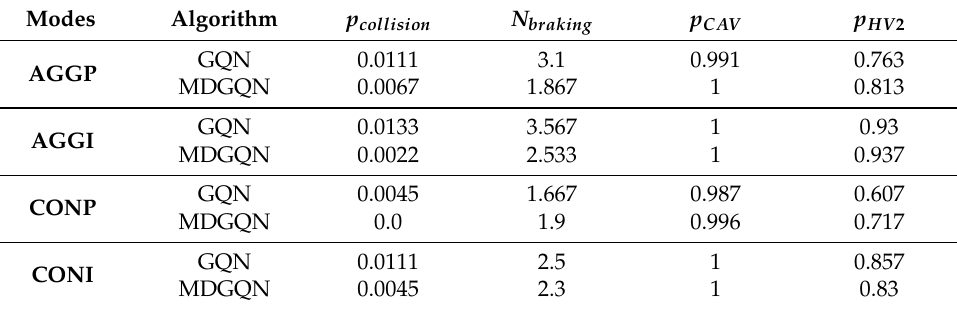
Figure 7. Average longitudinal velocity of CAVs and total traffic flow under four decision-making modes. The CAV-GQN means the average longitudinal speed of CAVs under the training of the GQN algorithm. The CAV-MDGQN represents the average longitudinal velocity of CAVs under the MDGQN algorithm training. The V-GQN indicates the average longitudinal speed of the total traffic flow under the training of the GQN algorithm. The V-MDGQN indicates the average longitudinal velocity of total traffic flow under MDGQN training. The two ends of the error rod indicate the maximum and minimum values of the test values. Table 6. Test evaluation